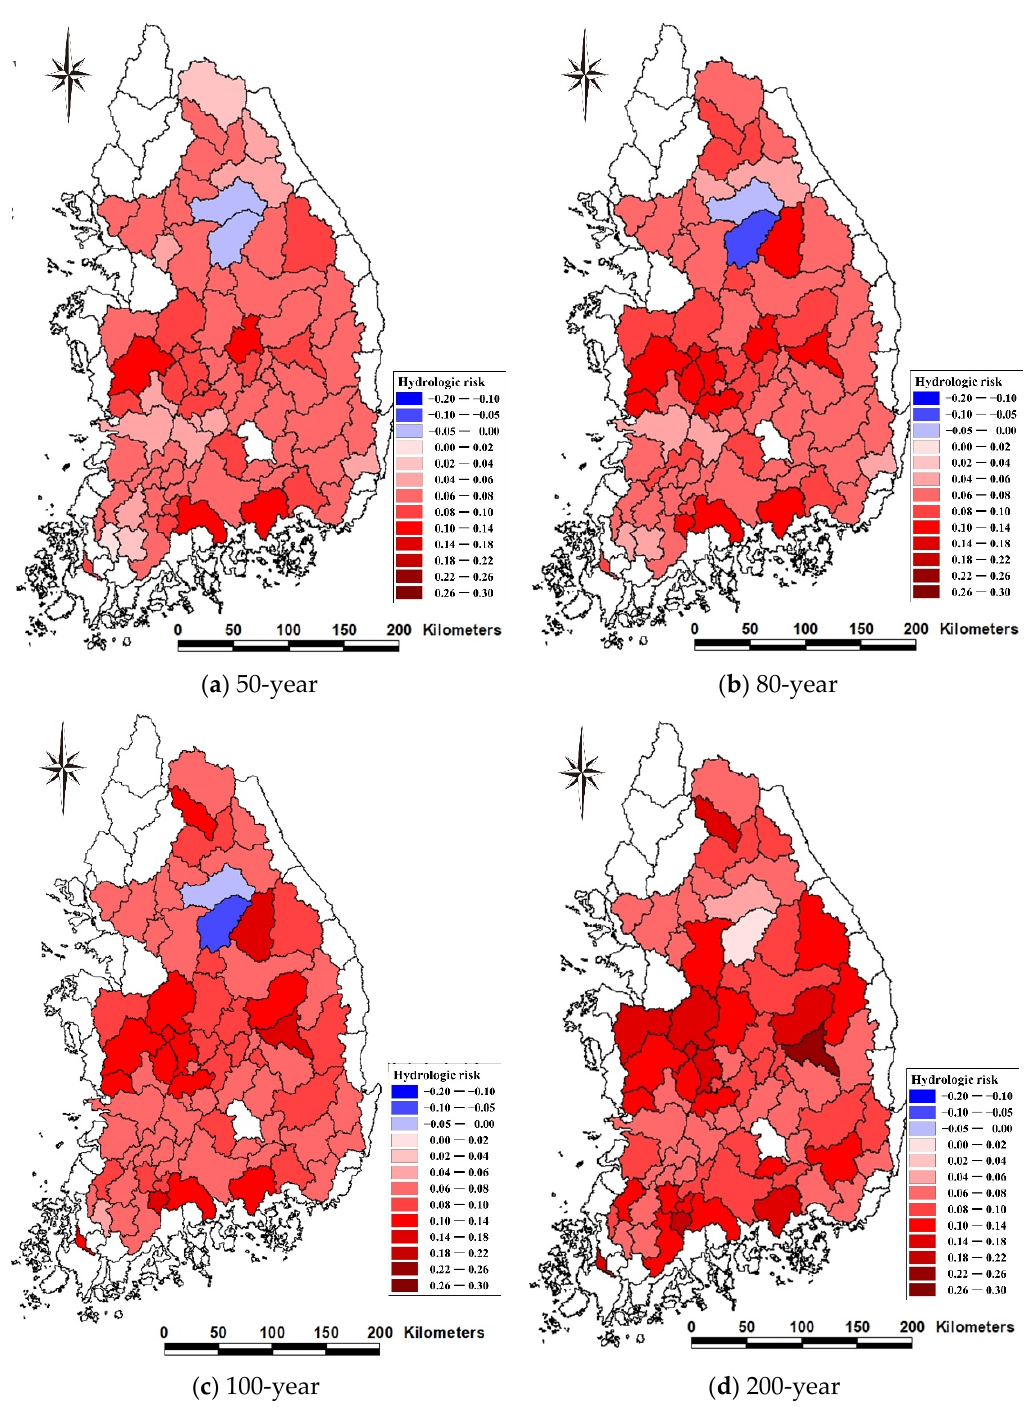
Figure 10. Hydrologic risk map of the RCP 4.5 for the total period.